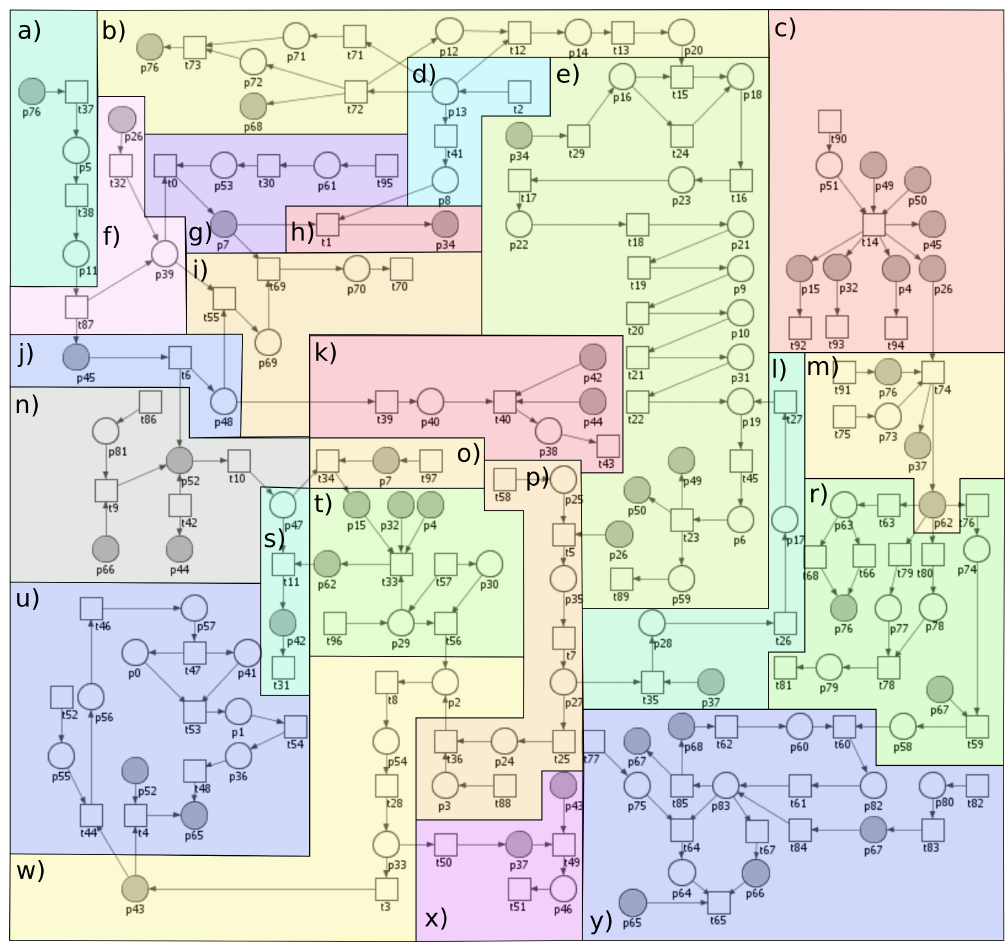
Figure 5. The proposed model has been divided into parts corresponding to the biological phenomena: ( a ) Janus kinases and signal transducer and activator of transcription (JAK-STAT) pathway stimulated by interferon gamma (IFN γ ); ( b ) innate immune responses; ( c ) p50/p65 translocation to the nucleus in macrophages M1, smooth muscle cell (SMC) and endothelial cell (EC); ( d ) gram-negative bacterial infections; ( e ) activation of nuclear factor kappa-light-chain-enhancer of activated B cells (NF- κ B)—the canonical pathway via I κ B α phosphorylation by kinase complex (IKK) (MyD88-dependent signaling pathway); ( f ) activation of caspase 1 (by tumor necrosis factor (TNF) and also by binding with STAT binding element (SBE) sequences of interferon regulatory factor I (IRF1); ( g ) IL-18 synthesis (caspase 1-dependent pathway); ( h ) IL-18-IL-18R complex formation; ( i ) negative regulation of IL-18 (by inhibition of caspase 1) caused by nitric oxide (NO); ( j ) NO synthesis; ( k ) cardiovascular disease influenced by NO-dependent pathway; ( l ) TNF receptor-associated factor 2 (TRAF2) and receptor-interacting serine/threonine-protein (kinase 1 (RIP1) ubiquitination; ( m ) macrophages polarization; ( n ) lipid peroxidation (oxLDL); ( o ) IL-18 synthesis (caspase 1-independent pathway) and neighboring endothelial cells stimulation; ( p ) regulation of TNFR1 signaling; ( r ) the role of IL-1, IL-23, IL-6, high level of IL-10 and IL-12 (released by classically activated macrophages M1); ( s ) atherosclerosis progression; ( t ) attracting of monocytes (classically activated macrophages M1); ( u ) formation of apoptosome and activation of effector caspases 3, 6, 7; ( w ) high level of active caspase 8; ( x ) inhibition of caspase 8 and inhibition of apoptosis (by a high level of cFLIPs); ( y ) STAT6 upregulation promotes M2 macrophage polarization to suppress